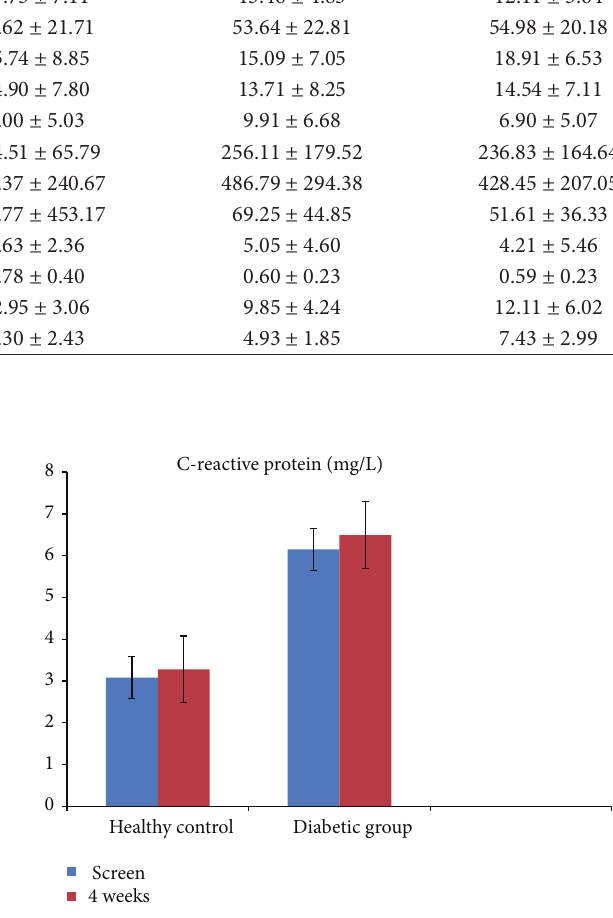
Figure 3: Serum C-reactive protein in healthy controls ( 𝑛 = 9 ) and in patients with type 2 diabetes ( 𝑛 = 8 ) before and after (4 weeks) pomegranate polyphenol supplementation. Data presented as mean ±